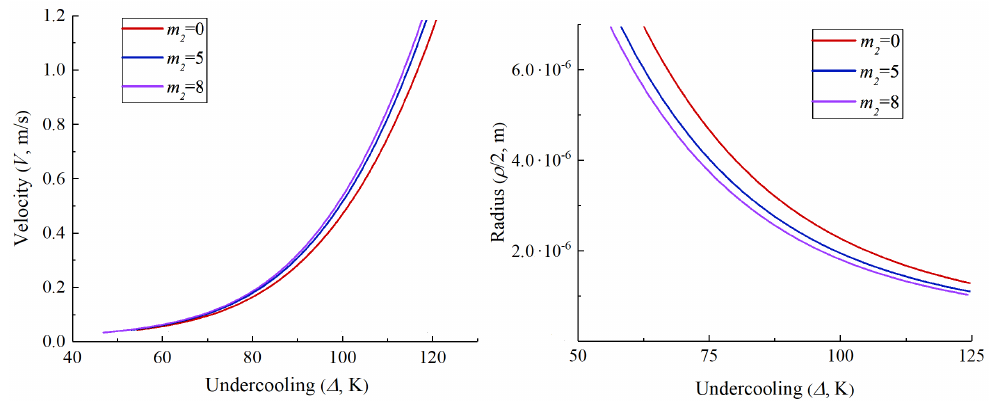
Figure 2. Dendrite tip velocity V and radius ρ /2 as functions of the melt undercooling ∆ for the TiAl alloy. The colored lines represent the effect of quadratic liquidus m 2 . The parameters used in the calculation are: solidification temperature T d 0 = 1748 K, hypercooling T Q = 272 K, impurity concentration C d ∞ = 55 at.%, distribution coefficient k 0 = 0.8, liquidus slope m 1 = − 8.8 K (at.%) − 1 , diffusion coefficient in liquid D C = 8.27 × 10 − 9 m 2 s − 1 , temperature diffusivity D T = 7.5 × 10 − 6